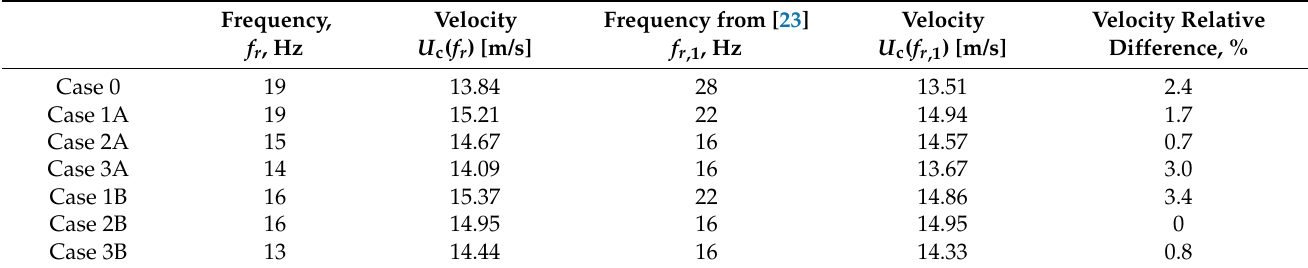
Table 3. Resonant frequencies and velocity.